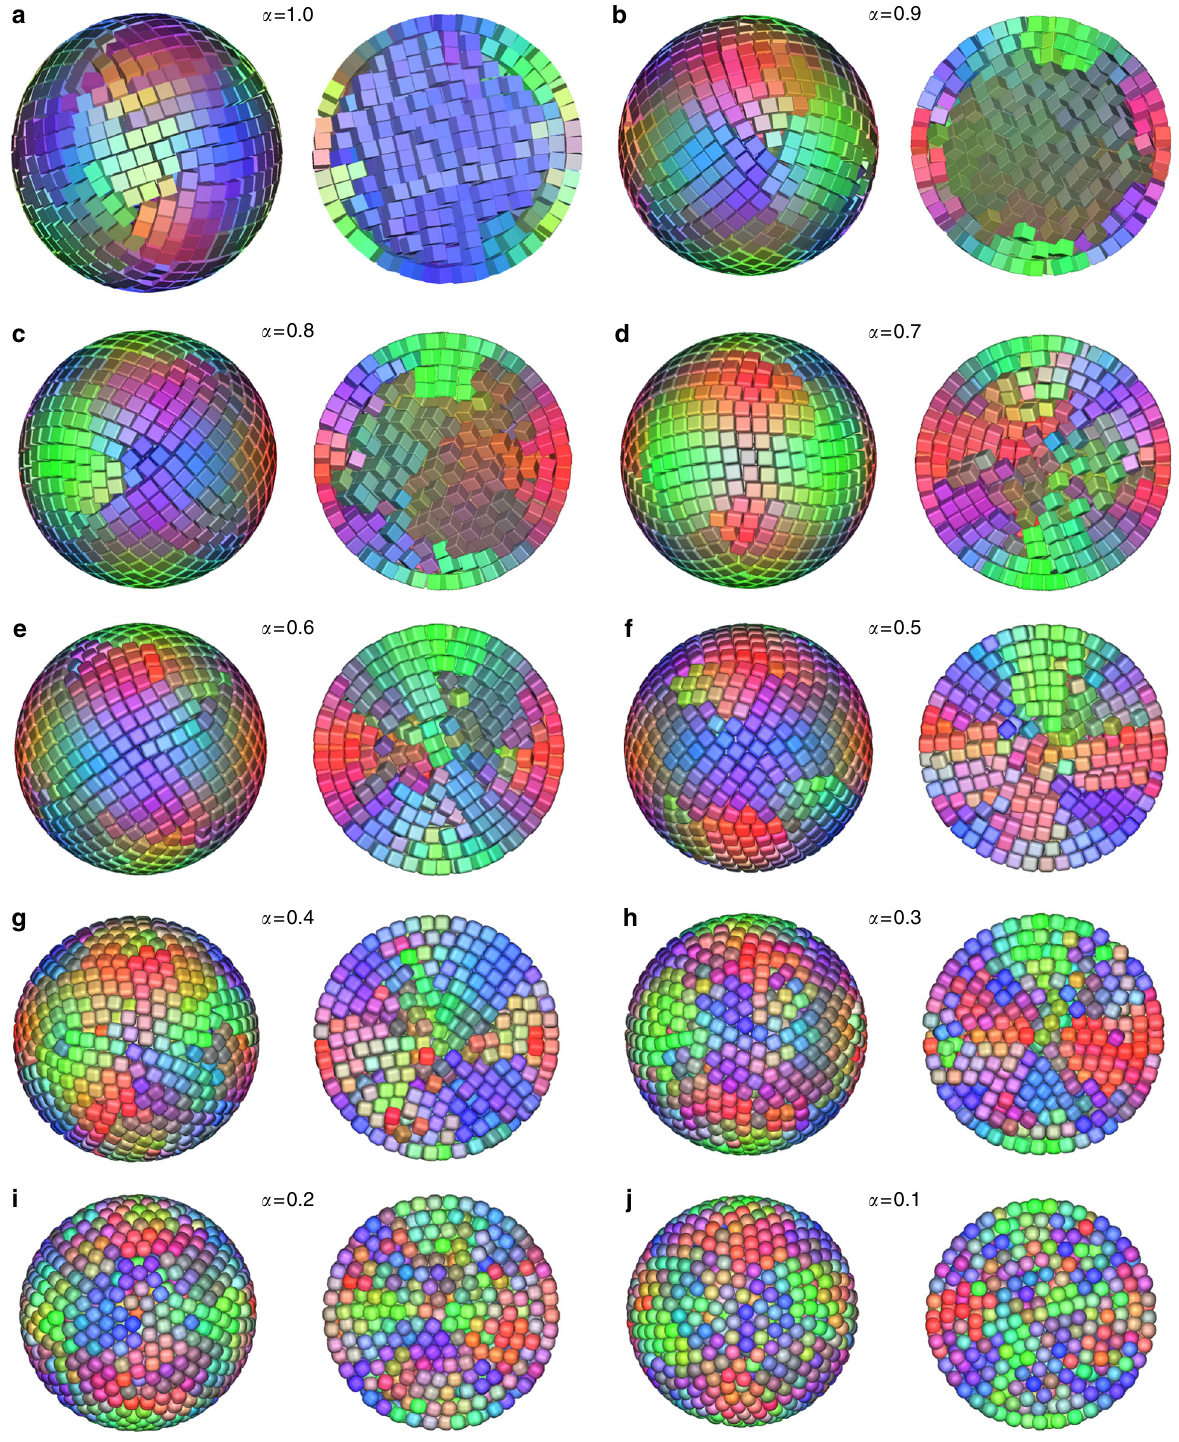
Fig. 4 Clusters from computer simulations with varying asphericity or roundness α . Fully compressed con fi gurations as obtained from computer simulations with 2000 particles in spherical con fi nement with different shape parameters. a – j : α = 1.0 (perfect cube), 0.9, 0.8, 0.7, 0.6, 0.5, 0.4, 0.3, 0.2, and 0.1, respectively. Different colors represent different orientations. For interactive 3D views, see Supplementary Data 1 and 4 –